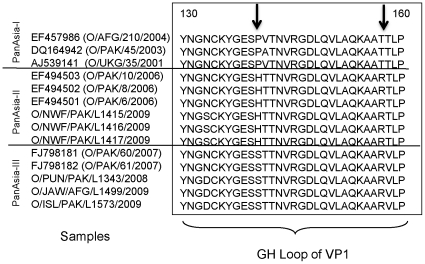
Diversity within VP1 amino acid sequences from PanAsia serotype O FMDVs including recent strains in circulation in Pakistan and Afghanistan.Amino acid sequences for the G-H loop portions of the VP1 capsid protein (which is important for FMDV antigenicity and receptor binding) were derived from reference PanAsia I and PanAsia II strains available in GenBank (accession numbers are indicated) and aligned with the derived VP1 sequences from current serotype O strains circulating in Pakistan and Afghanistan obtained in this study. The positions of shared amino acid substitutions are indicated by arrows.